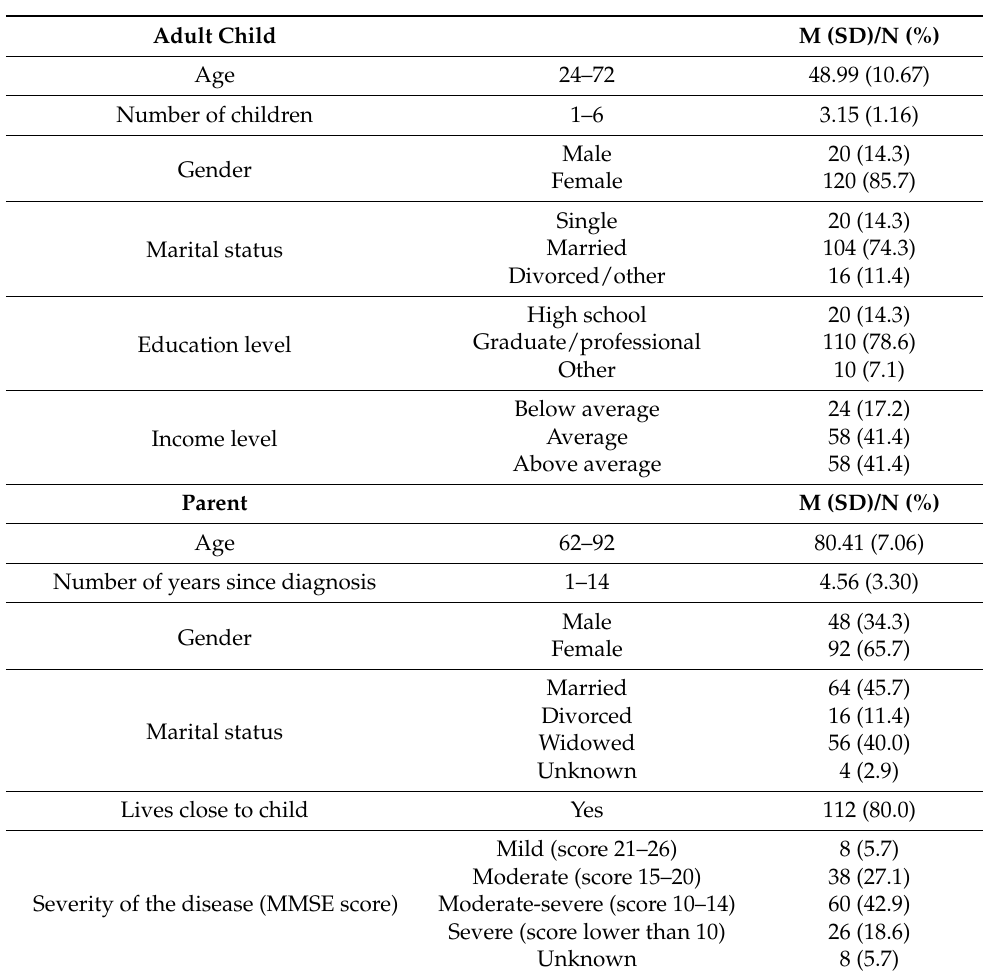
Table 1. Background Data for Adult Children and Parents ( N =